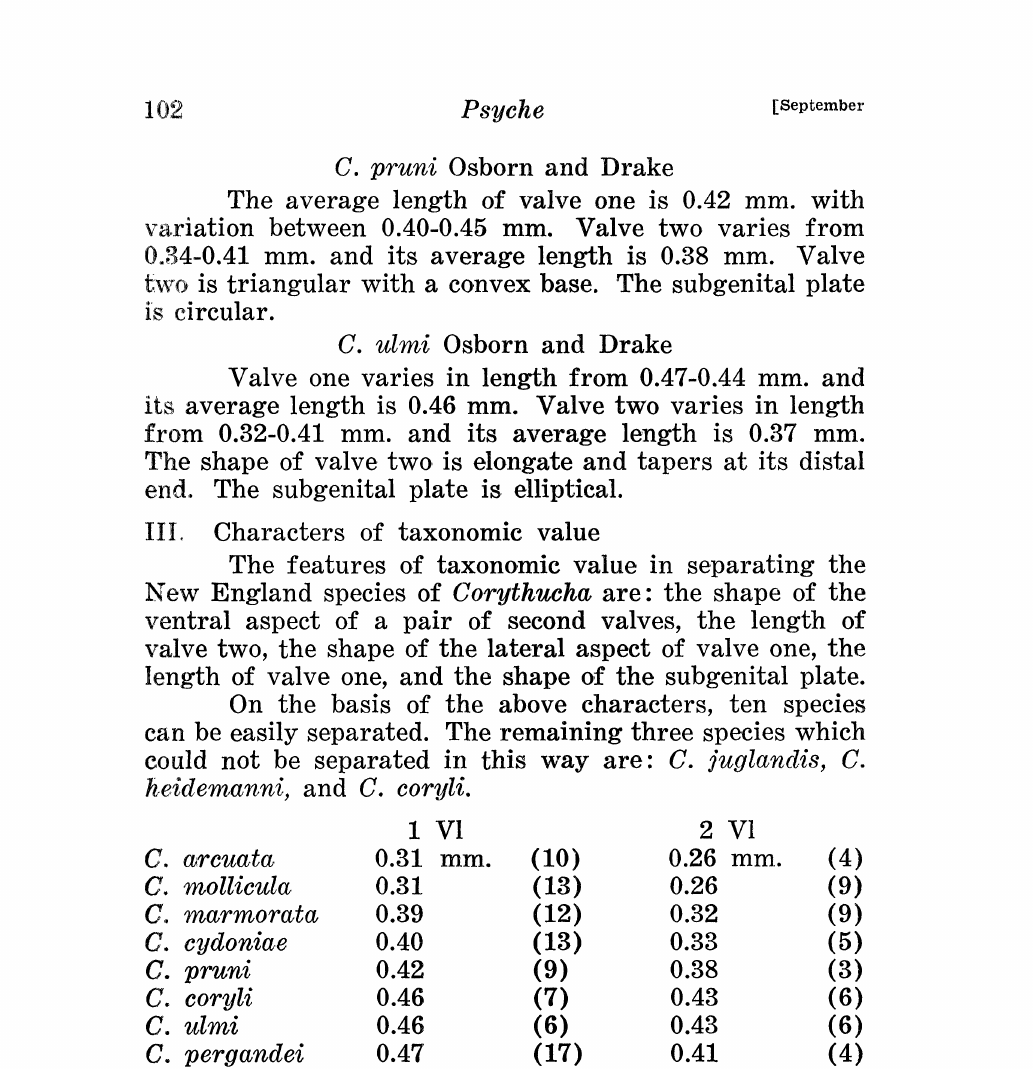
Table 1. Average comparative lengths of valves one and two. The numbers in parenthesis indicate the actual number of measuremerts determined for each